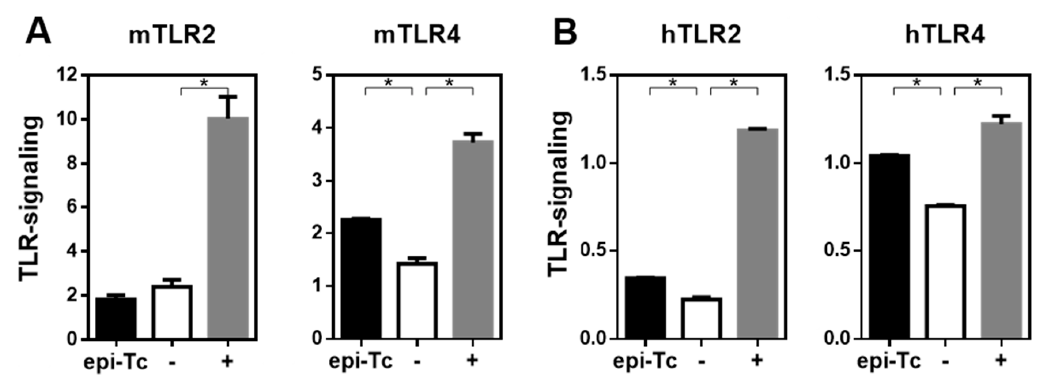
Figure 8. T. cruzi epimastigote lysate induces TLR-signalling: T. cruzi lysates were incubated with HEK-293 cells (50,000/well) expressing either murine TLR2 or TLR4 ( A ) and human TLR2 and TLR4 ( B ) overnight at 37 °C. Positive controls (+) consisted of LPS for TLR4 and in PAM3CSK for TLR2, while negative ( − ) control consisted of cultured cells in medium. Afterwards, the production of IL-8 or the quantification of phosphatase alkaline in cell culture was detected in the culture supernatant by specific sandwich ELISA or by direct absorbance measure with a spectrophotometer, respectively. Representative results from three independent experiments are shown (±SEM, indicated by error bars). Asterisks indicate statistically significant differences (* p < 0.05) by student t -test.